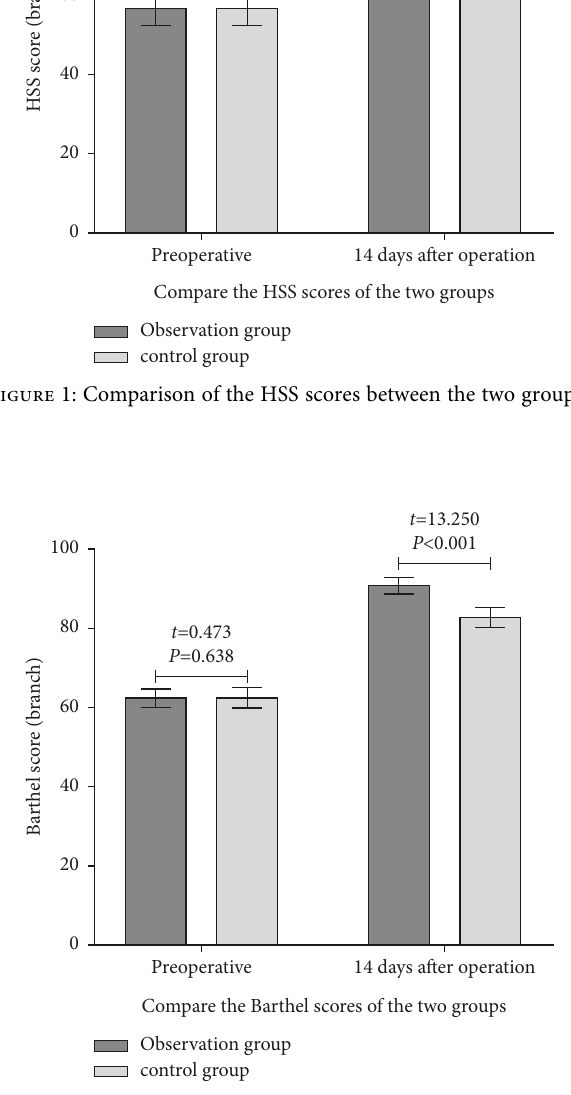
Figure 2: Comparison of the HSS scores between the two groups.